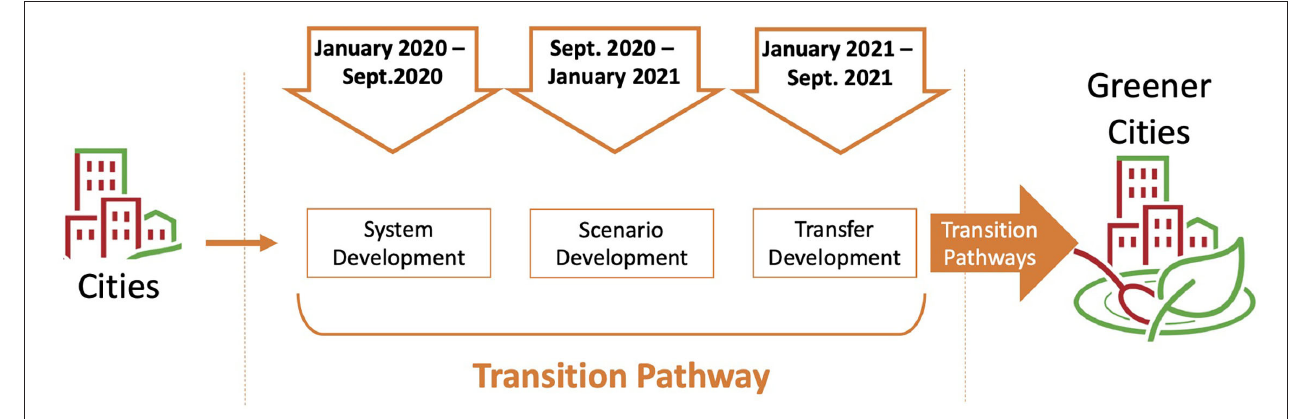
FIGURE 1 | Overview transition pathway methodology—initial schedule (Manderscheid et al., 2019).